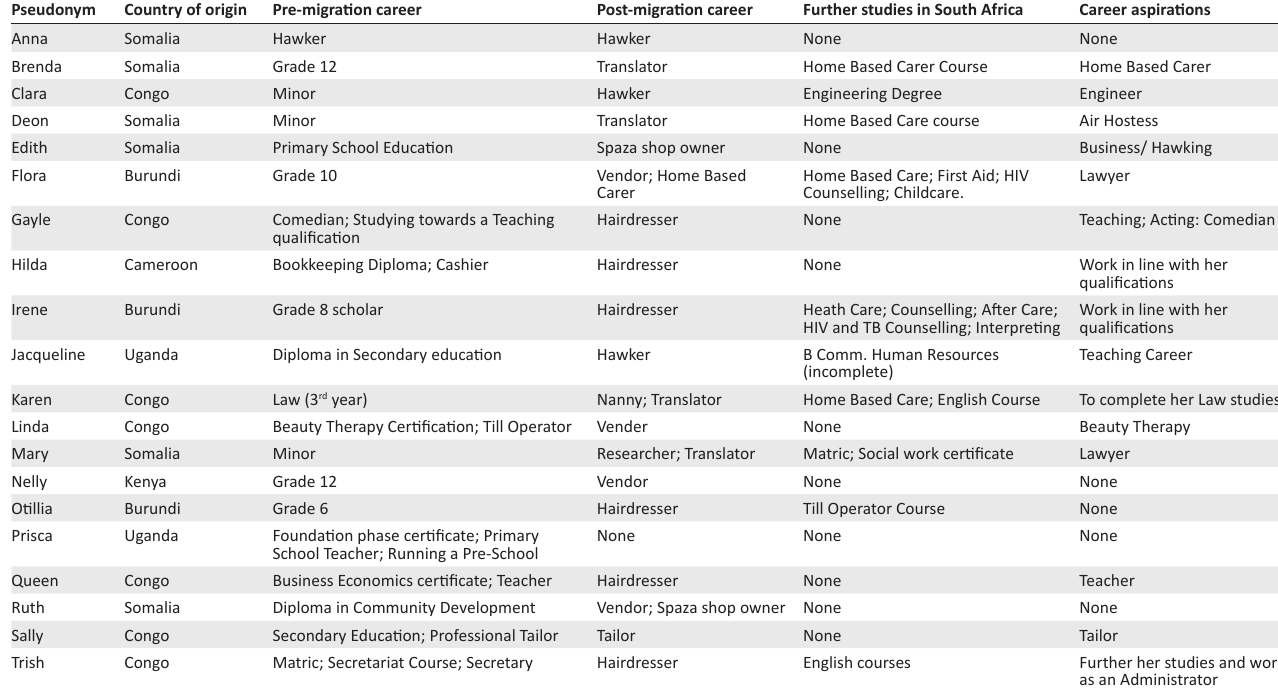
TABLE 1: Participants profile. Pseudonym Country of